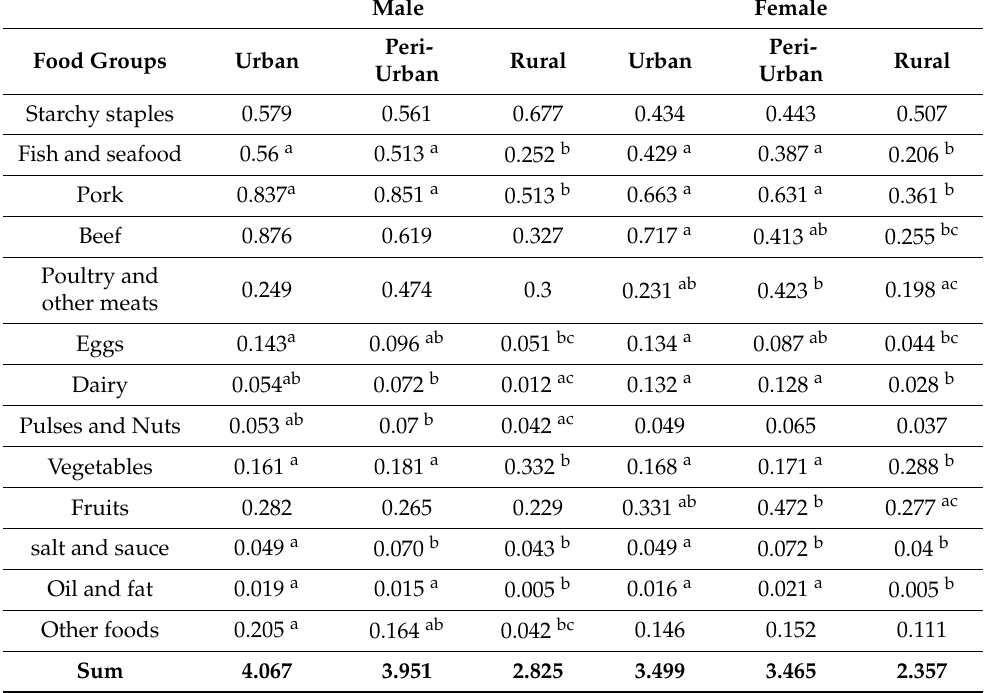
Table A4. GHGE according to the daily individual daily calorie intake by food group, gender, and